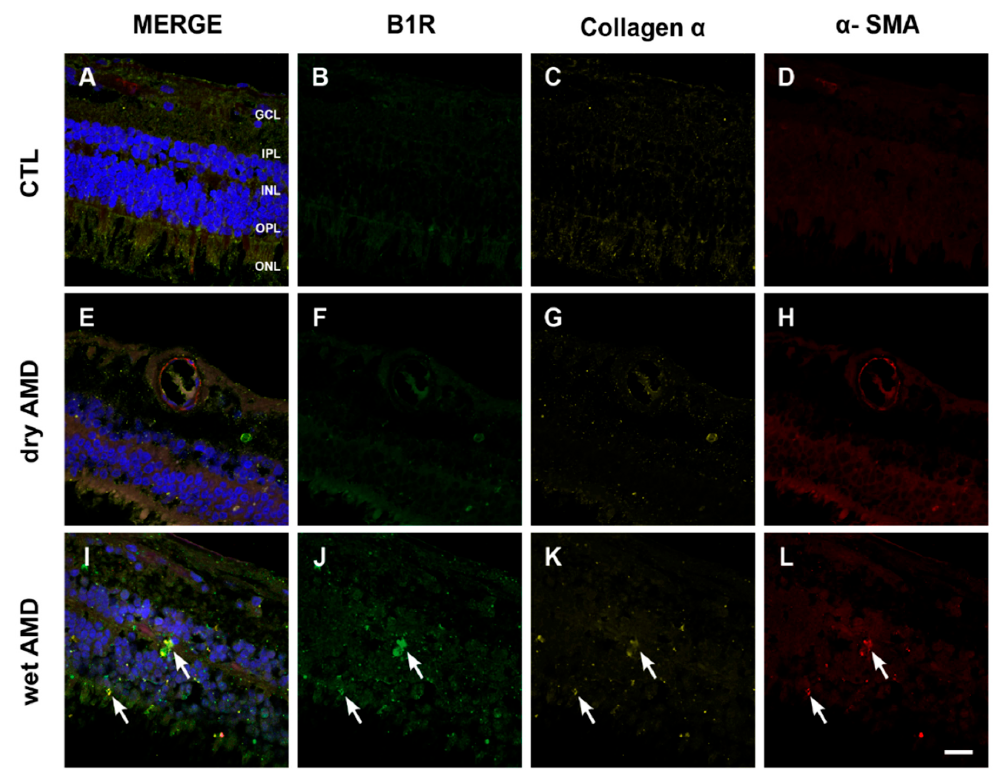
Figure 7. B1R colocalization with fibrosis markers in human retinae. ( A – L ) Microphotographs showing collagen 1 α (yellow) and α -SMA (red) immunoreactivity and their co-expression with the B1R (green) in human retinae. Collagen 1 α and α -SMA immunoreactivity was slightly detectable in the dry AMD ( G and H ) and control retinae ( C and D ), but strongly increased in the wet AMD retinae (arrows in K and L). A colocalization of collagen 1 α and α -SMA with B1R was observed in the outer layers of the wet AMD ( I ) but not in the dry AMD (E) or control ( A ) retinae. Sections are all counterstained for 4 ′ ,6-diamidino-2-phenylindole (DAPI; blue), which labels cell nuclei ( A , E , I ). Images were obtained at 40×. Scale bar: 20 μ m. GCL: ganglion cell layer, IPL: inner plexiform layer, INL: inner nuclear layer, OPL: outer plexiform layer, ONL: outer nuclear layer.